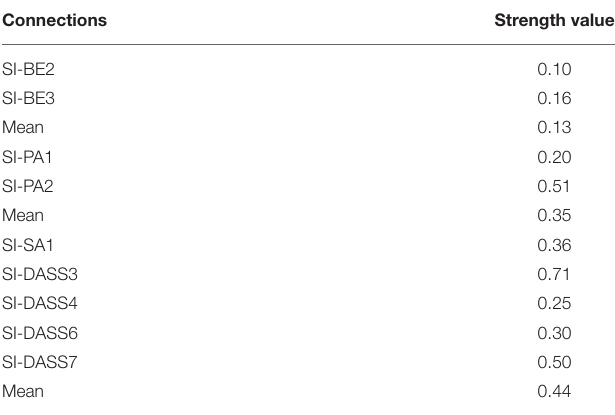
TABLE 7 | Strenght values of node-specific connections. Connections